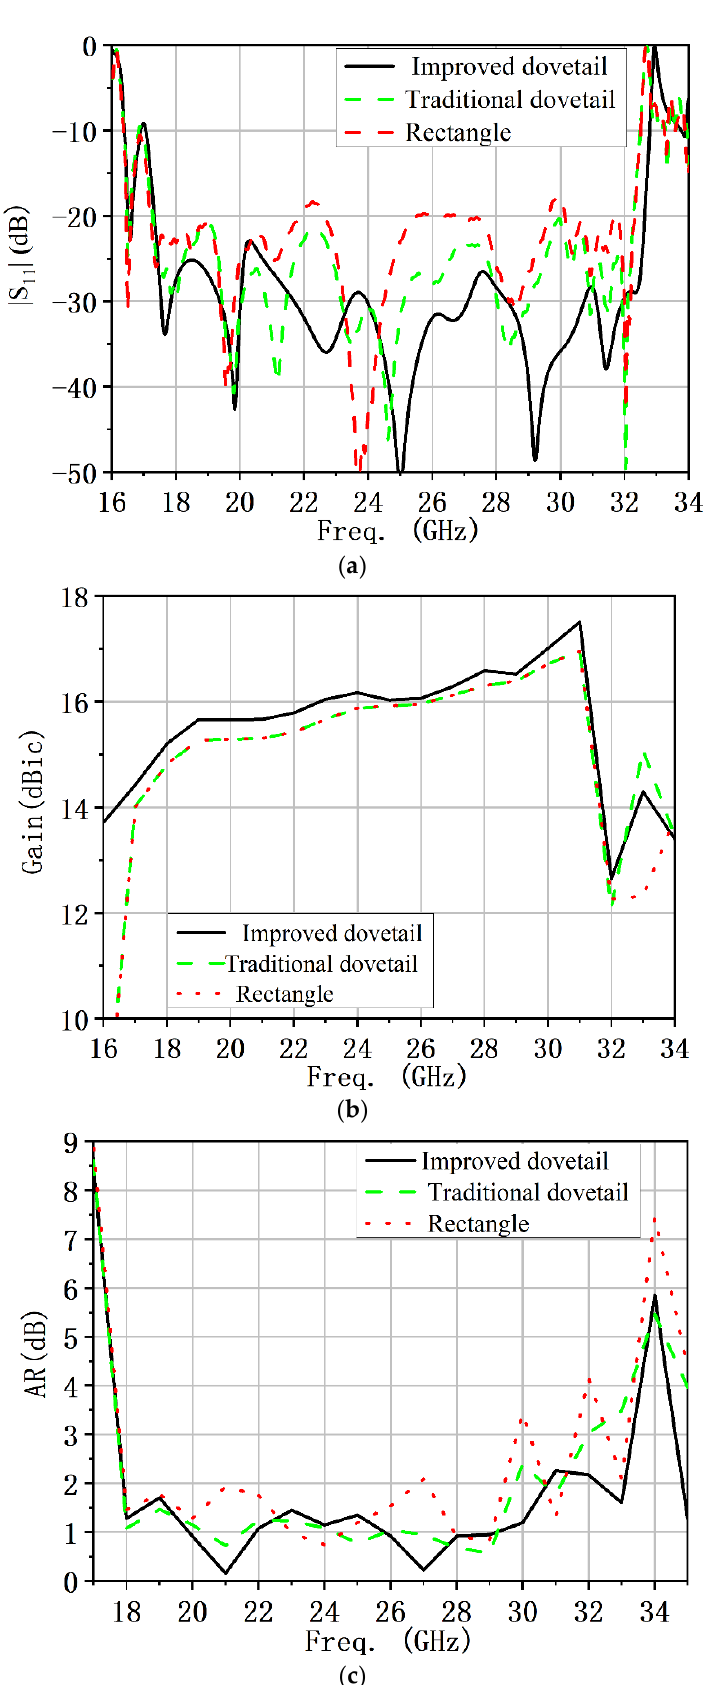
Figure 16. Comparison graph of simulation results of a circularly polarized horn antenna loaded with different circular polarizers: ( a ) |S 11 |. ( b ) Gain. ( c ) AR.